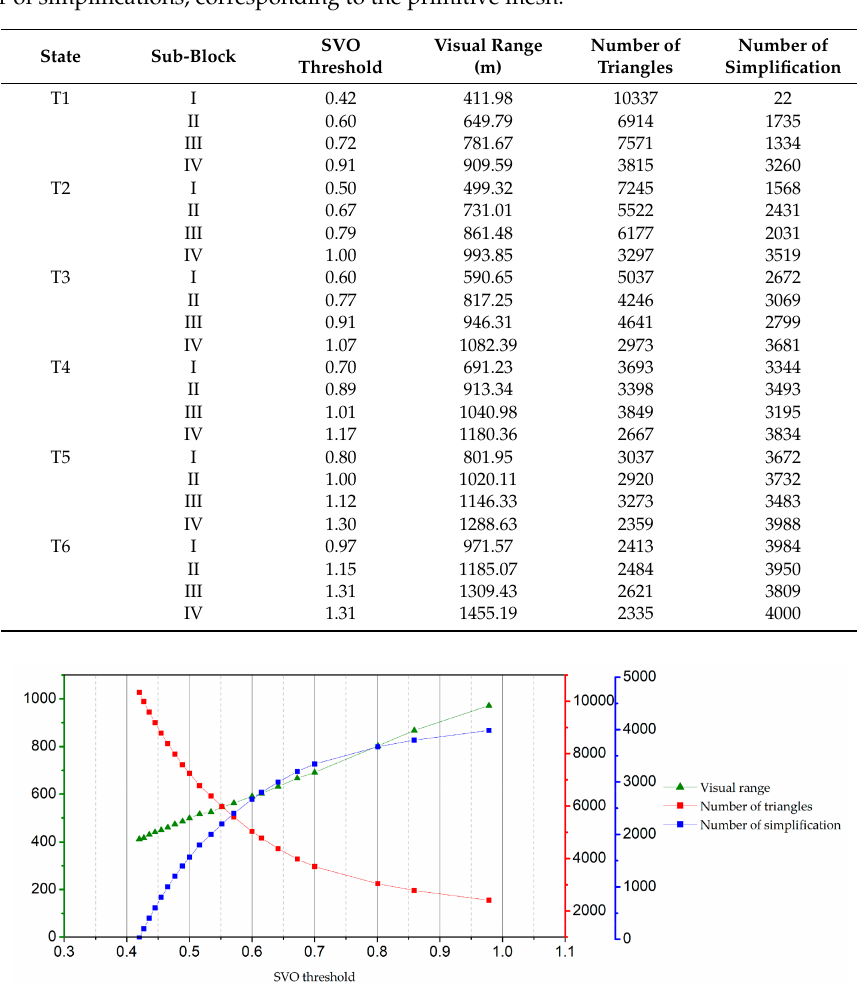
Figure 14. Relationship between the SVO threshold in sub-block I and the visual range, number of triangles, and number of relative simplifications. As the SVO threshold increases, the distance between the sub-block and the viewpoint increases approximately linearly. At the same time, the number of triangles in the sub-block continues to decrease, and the number of relative simplifications continues to grow.